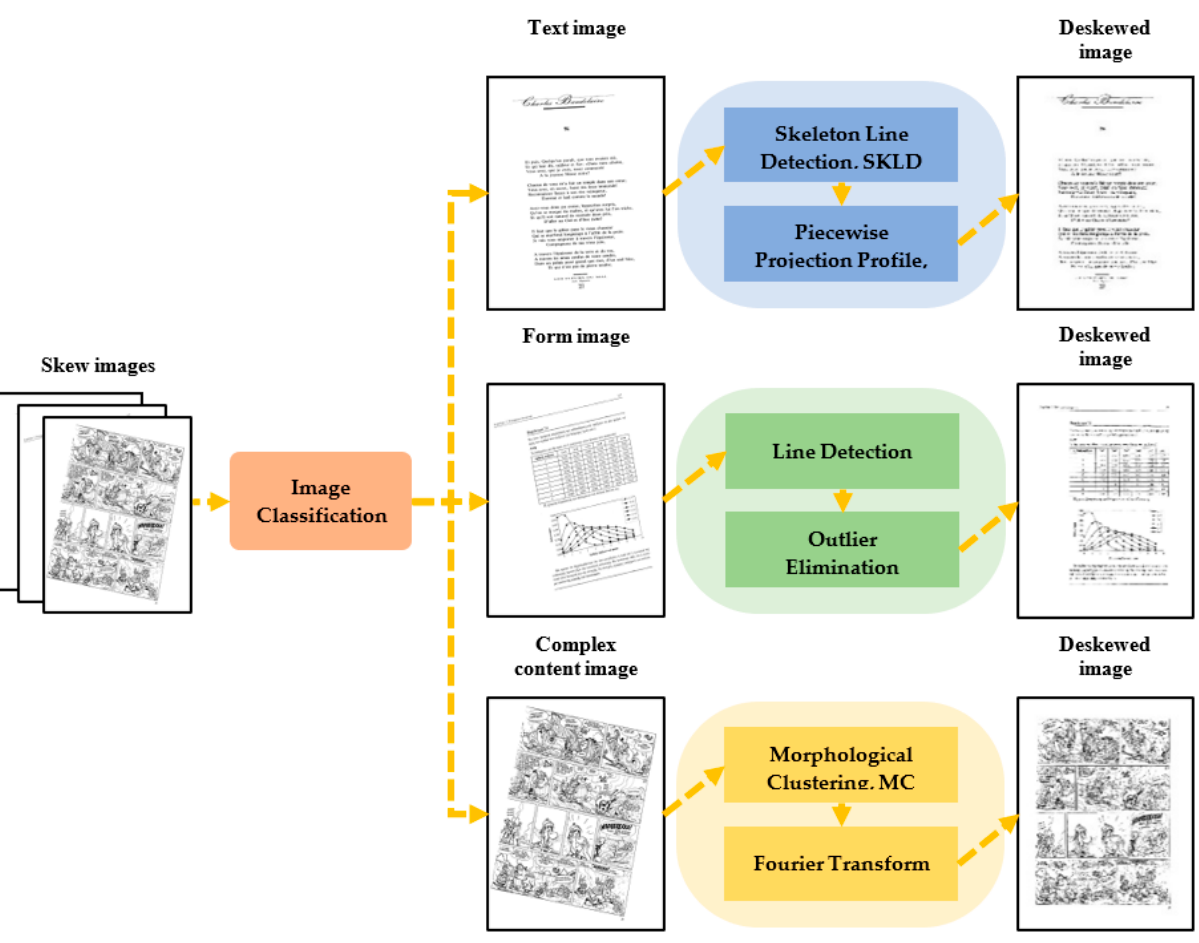
Figure 1. Illustration of the process of deskewing document image in our work.